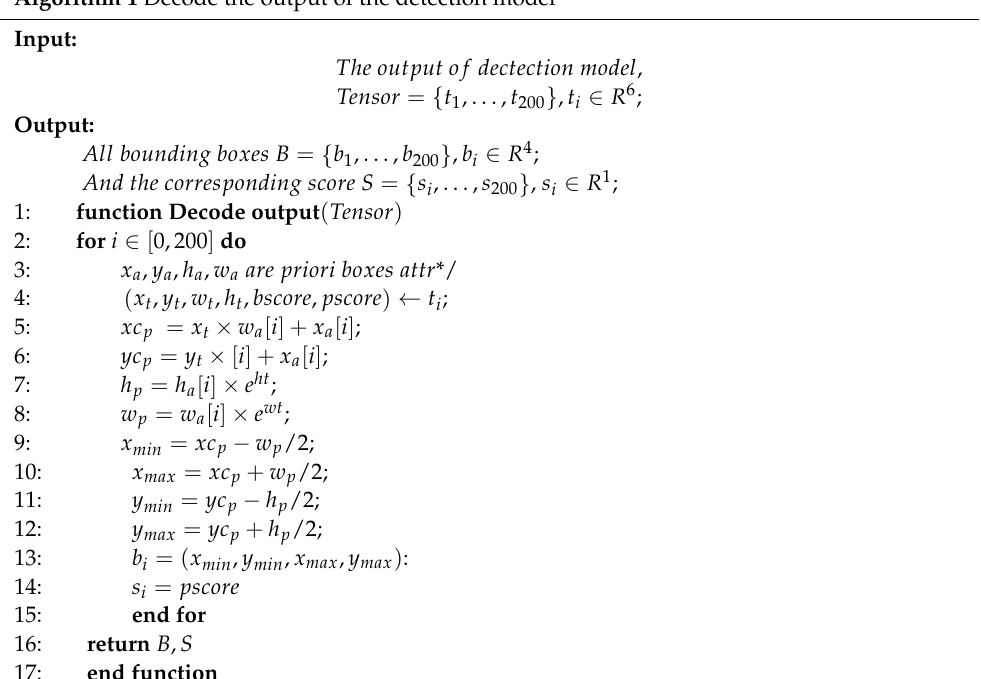
Algorithm 1 Decode the output of the detection model